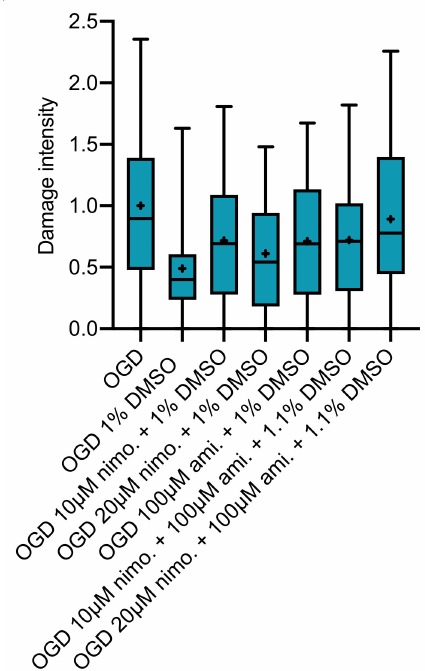
Figure 4. Slices receiving 10 ( n = 30) or 20 µ M ( n = 25) nimodipine in 1.0 Vol.% DMSO compared to slices receiving 100 µ M amiloride alone in 1 Vol.% DMSO ( n = 50) or in combination with 10 ( n = 56) or 20 µ M ( n = 59) nimodipine in 1.1 Vol.% DMSO. No significant di ff erence in cell damage intensity was observed at 72 h after OGD.